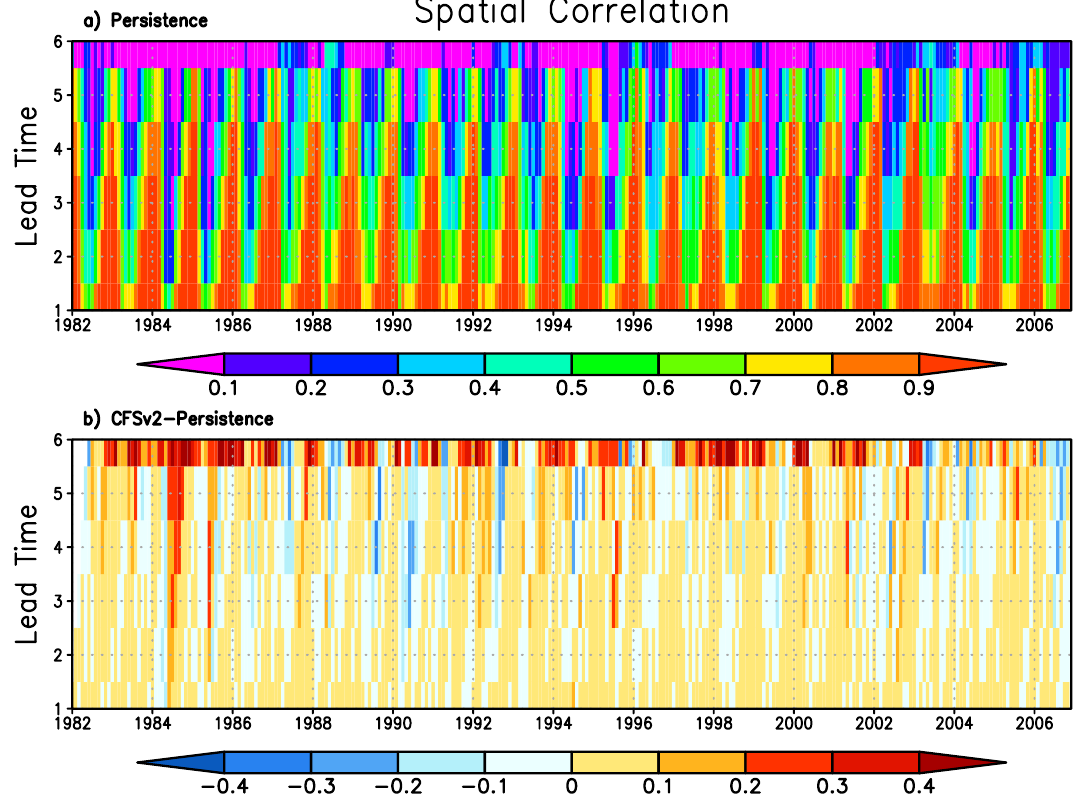
Figure 4. The spatial anomaly correlations of all 300 forecasts (horizontal axis) with six lead times (vertical axis) from the persistence forecast ( a ) and the differences between the CFSv2 forecast and persistence forecast ( b